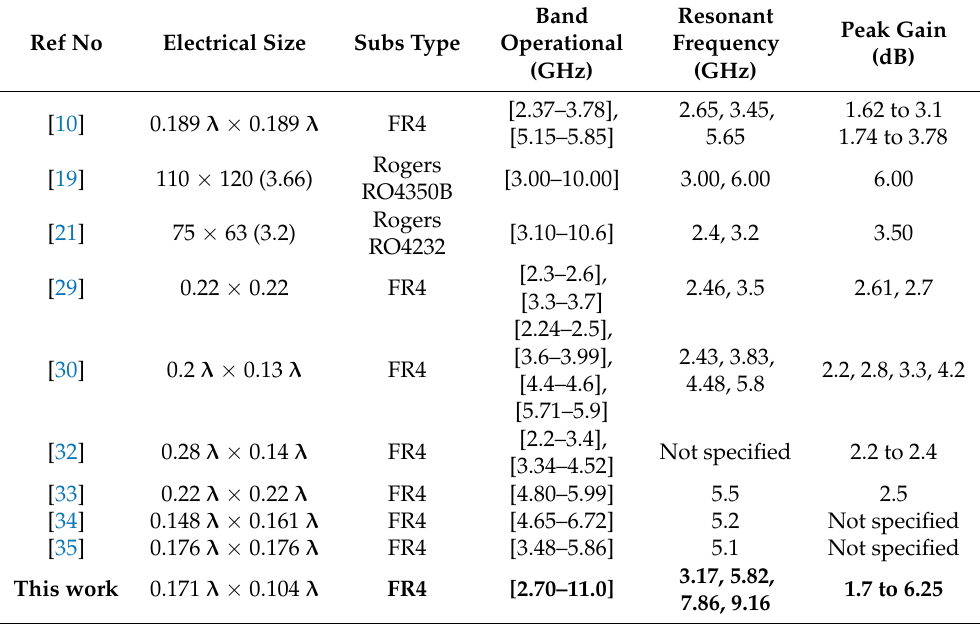
Table 3. Comparative evaluation of the suggested antenna against different published patches in the